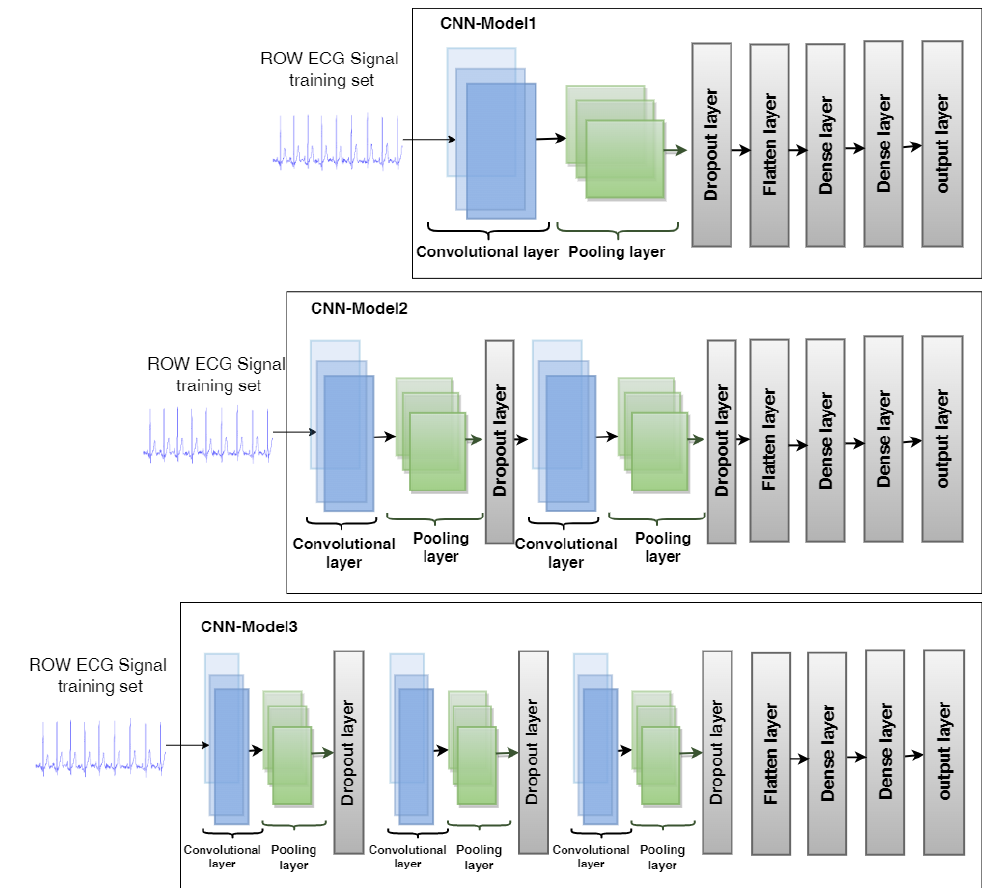
Figure 3. The layers structure of the three CNN models.